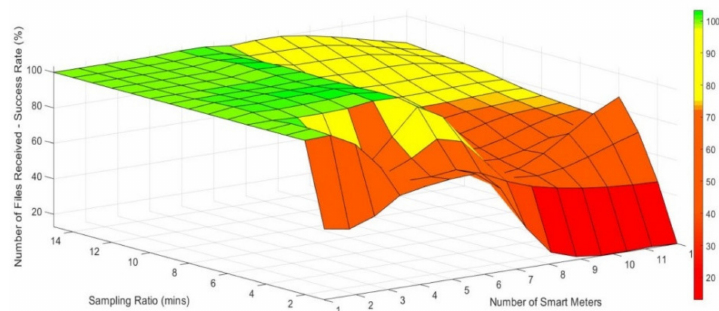
Figure 16. Visual representation of the success ratio of the number of files received as a function of the number of smart meters connected to the data concentrator and the smart meters’ sampling